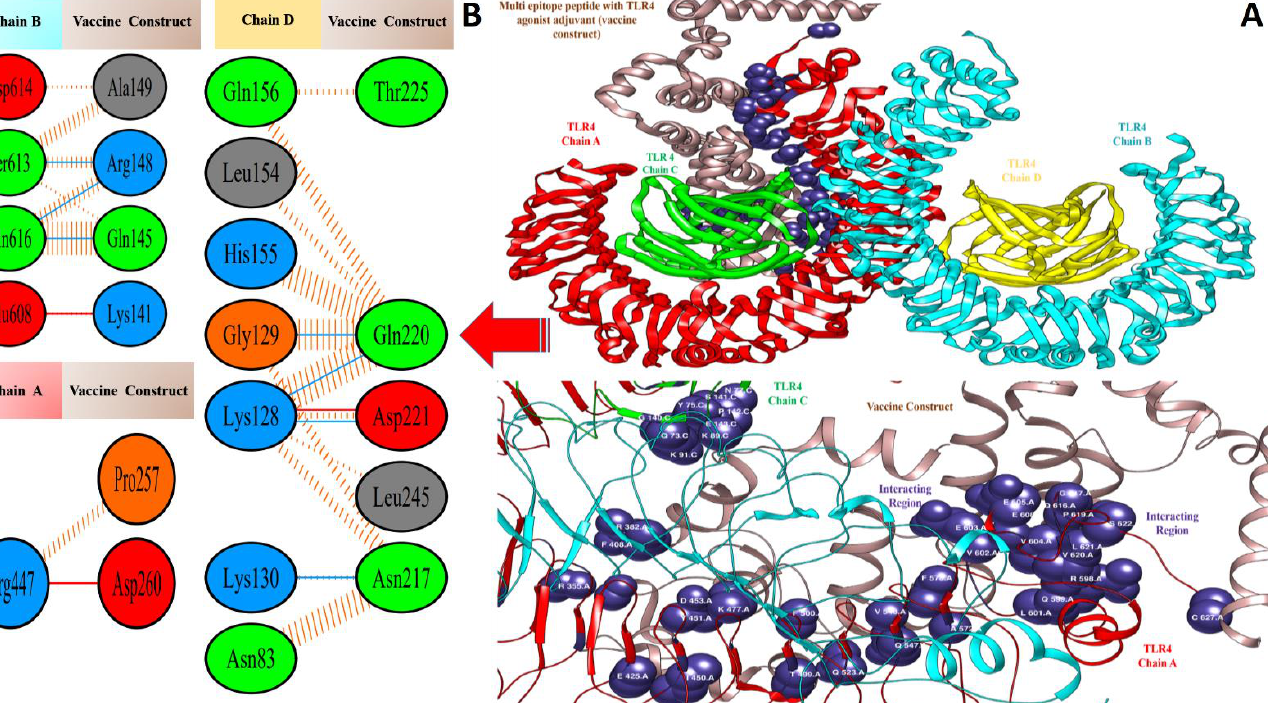
Figure 8. Docked pose of β -defensin vaccine with TLR4: ( A ) every single entity of the complex is self-explanatory. Each chain of the receptor TLR4 is represented in a different colour, i.e., chain A: purple, chain B: green, chain C: yellow, and chain D: dark red, and the designed vaccine construct β -defensin is represented in deep pink; interacting residues between receptor and vaccine are shown in navy blue. ( B ) Residue-residue interaction between vaccine construct and TLR4 chains